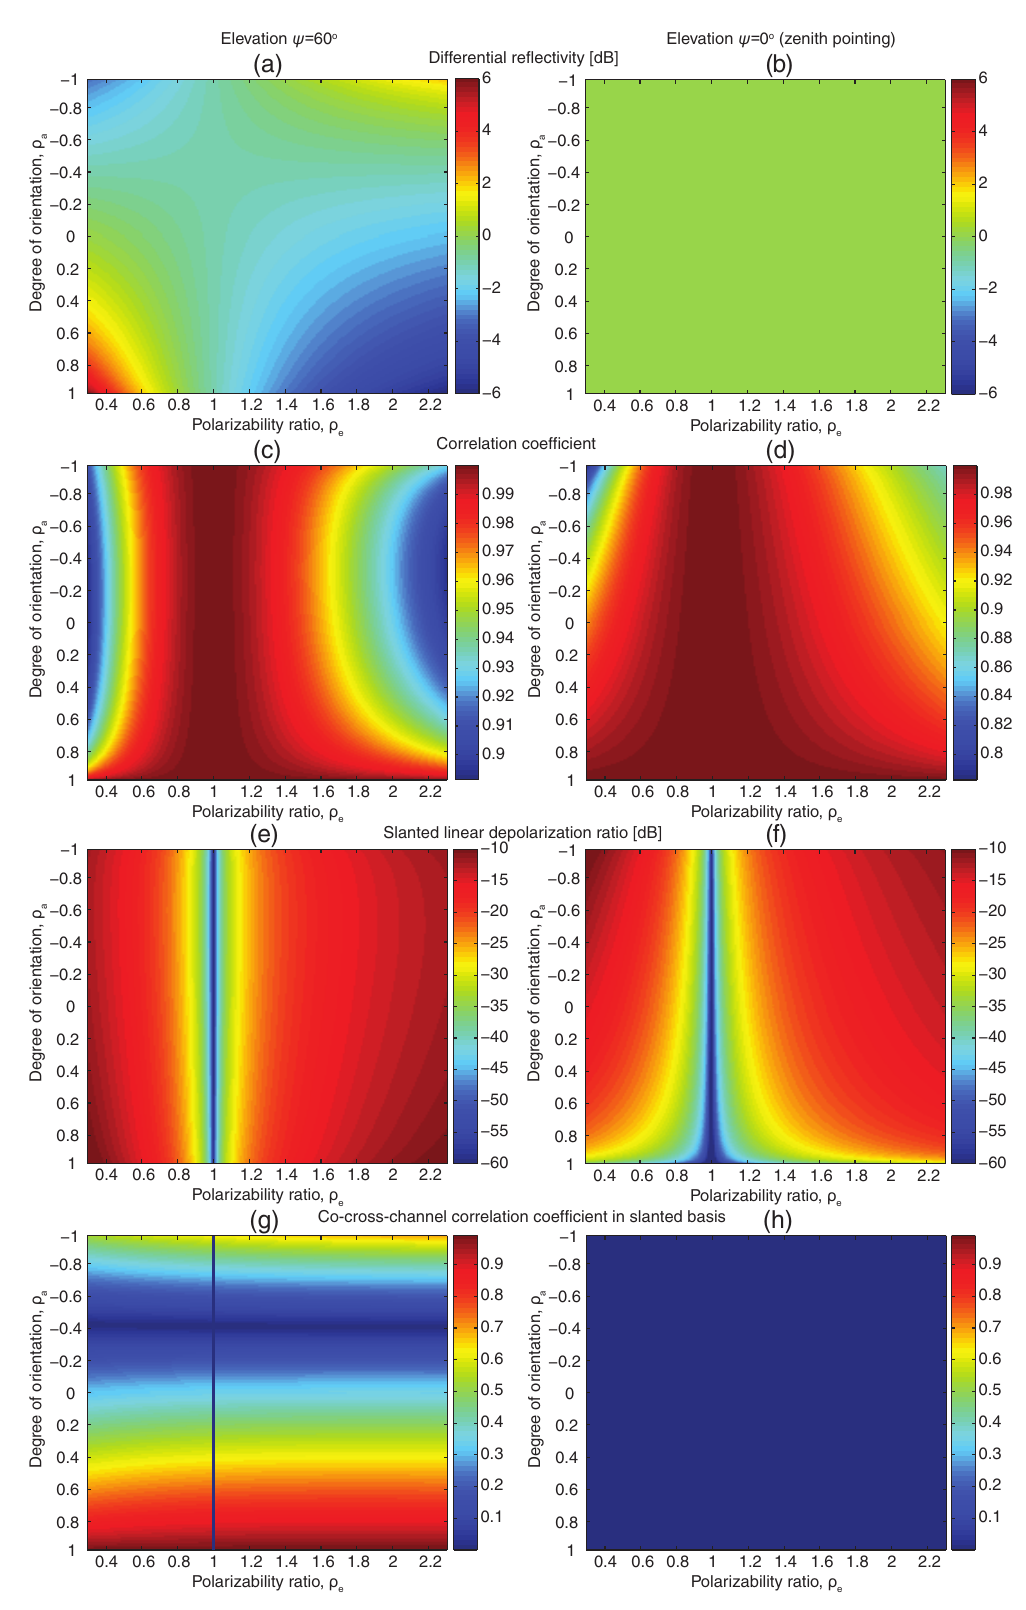
Figure 13. Modeled differential reflectivity ˆ Z DR ( a and b ), correlation coefficient ˆ ρ HV ( c and d ), slanted linear depolarization ratio (cid:92) SLDR ( e and f ), and co-cross-channel correlation coefficient in the slanted basis ˆ ρ CX ( g and h